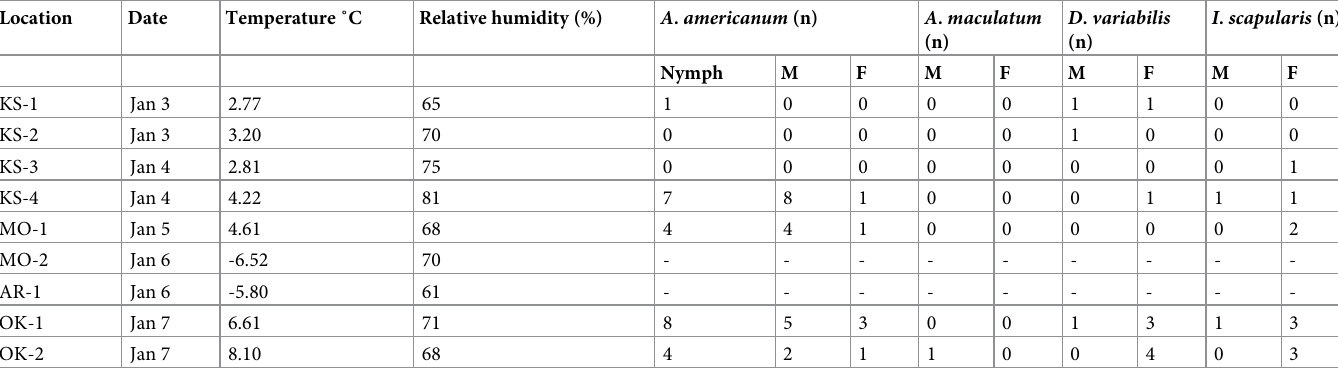
Table 1. Number of ticks caught in different locations during January 3 –January 7, 2017 and the ambient temperature and relative humidity. Location